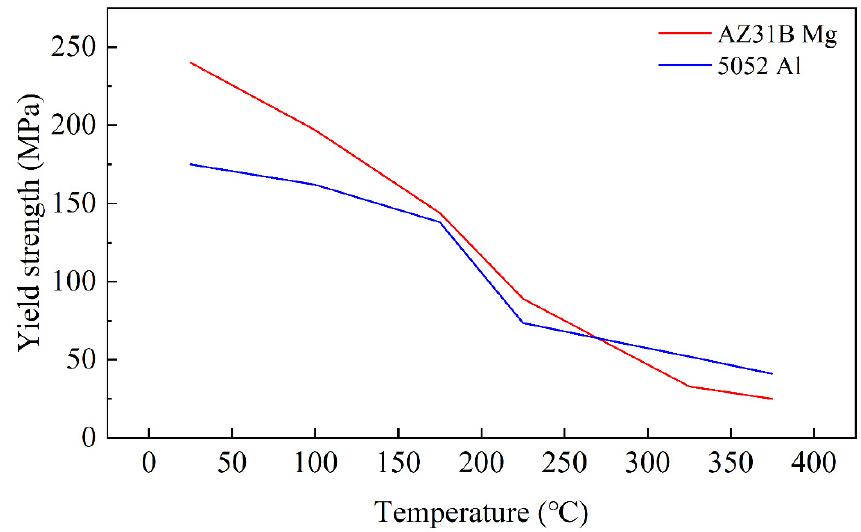
Figure 9. The yield strength curve with different temperatures.